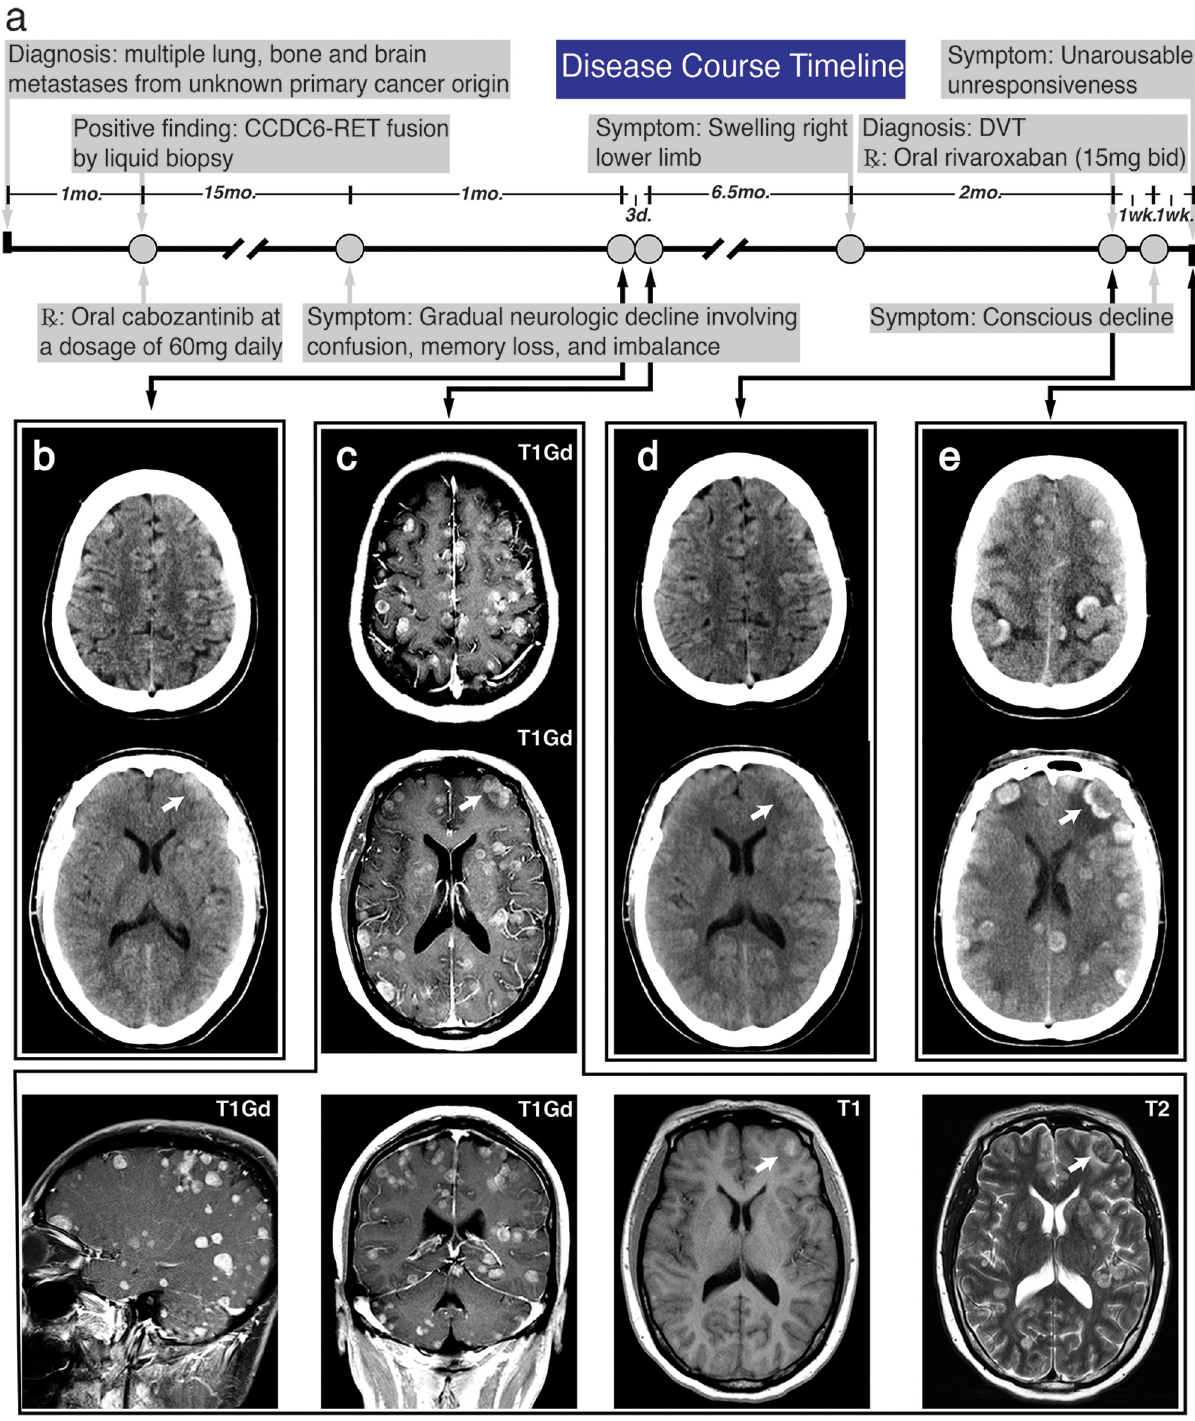
Figure 1: Timeline of major disease - related events and representative images of head imaging. ( a ) A schematic timeline displayed the major events during disease progression. ( b ) The initial head CT revealed extensive iso - dense and several hyperdense ill - de fi ned masses. ( c ) CE - MRI identi fi ed di ff use T1 gadolinium - positive ( T1 Gd +) lesions. Several high signals on T1 image indicated ITH, and typically hyperintense metastases were identi fi ed without signi fi cant mass e ff ects. ( d ) There was negative fi nding on head CT imaging when the patient was diagnosed with DVT. ( e ) The last head CT showed di ff use open - ring or hollow circles of hyperintensities with sulci e ff acement, compatible with di ff use hemorrhagic metastases. The white arrow pointed to a same hemorrhagic